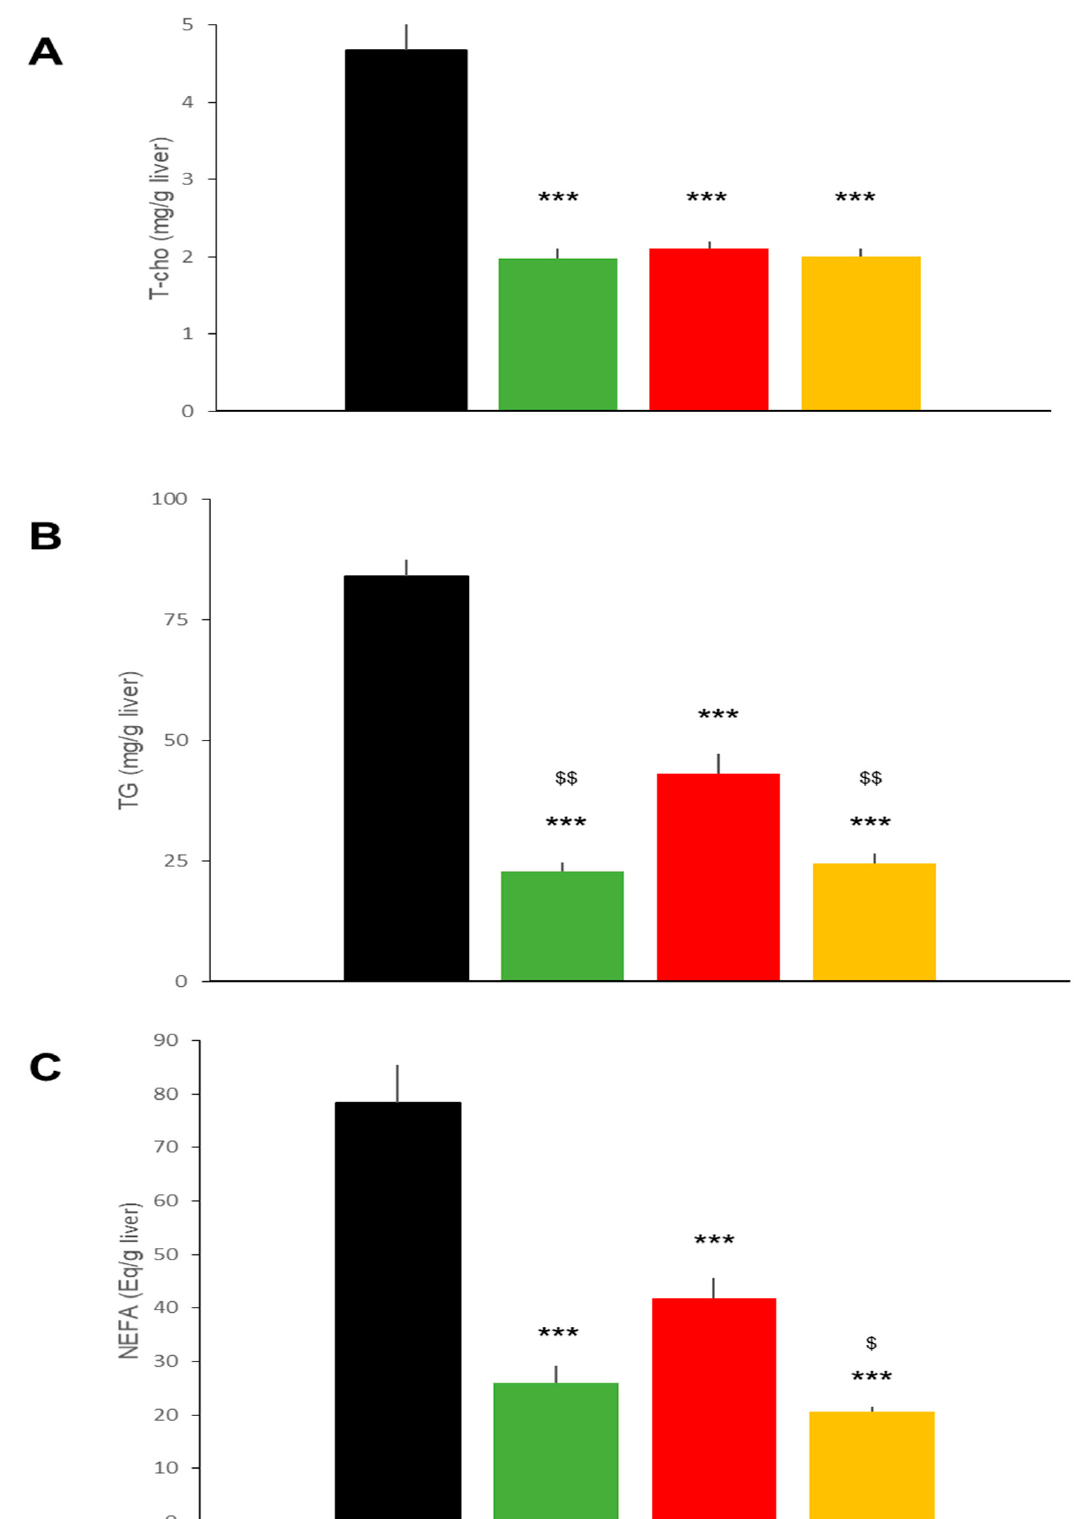
Figure 4. Effects of treatments with liraglutide and/or ipragliflozin on hepatic lipid contents in DIO mice. Hepatic total cholesterol ( A ), triglyceride ( B ), and non-esterified fatty acid ( C ) contents of vehicle-treated DIO mice and in mice treated with liraglutide and/or ipragliflozin. Data represent mean ± SE, n = 6, *** p < 0.001 vs. Control; $ p < 0.05, $$ p < 0.01 vs. IPRA group.